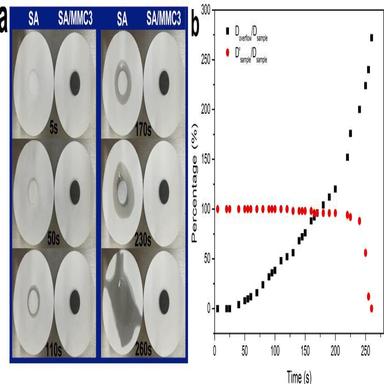
(a) Leakage photographs of SA and SA/MMC3; (b) Diameter ratios of leakage area of SA.